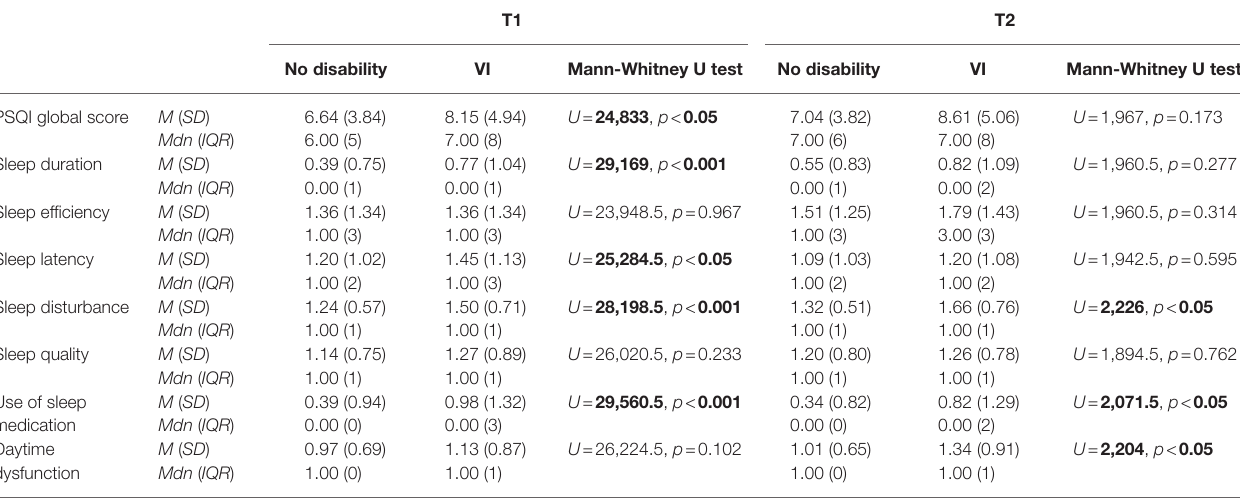
TABLE 4 | Between-group comparison of PSQI global and component scores for visual impairment (VI) and no disability